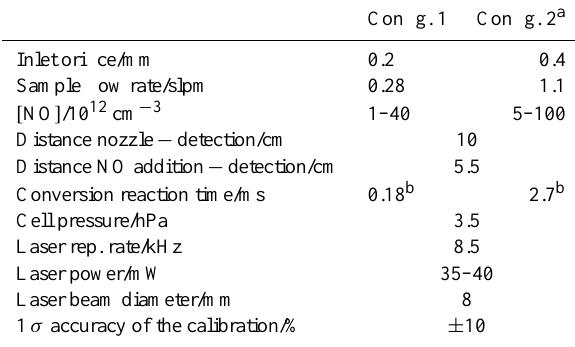
Table 1. Properties of the instrument regarding the HO 2